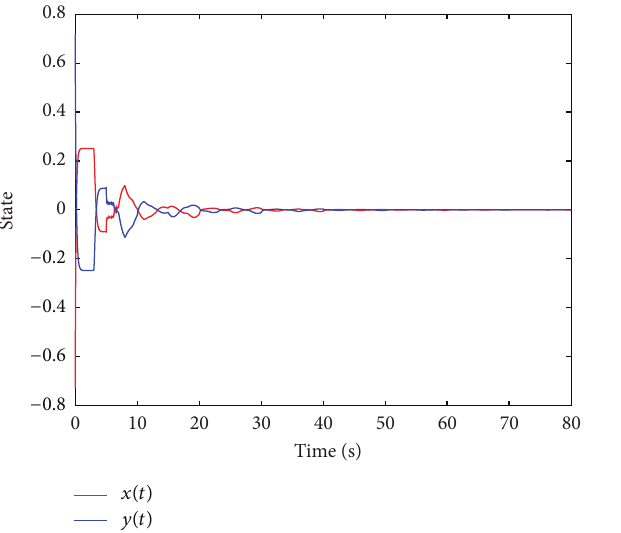
Figure 3: Simulation of the system (75) under the sliding intermit- tent control.